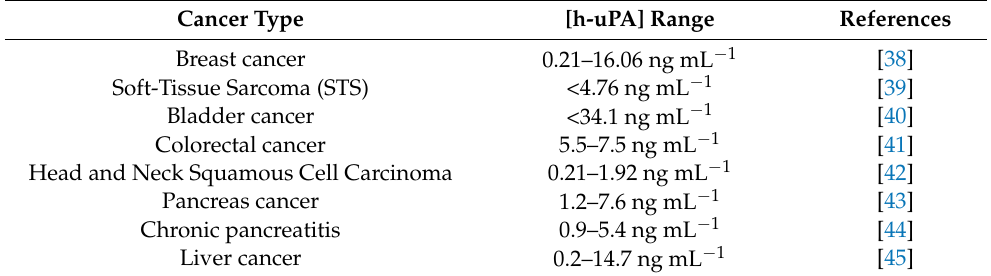
Table 1. Clinical concentration ranges of h-uPA in human serum for some cancer forms. Cancer